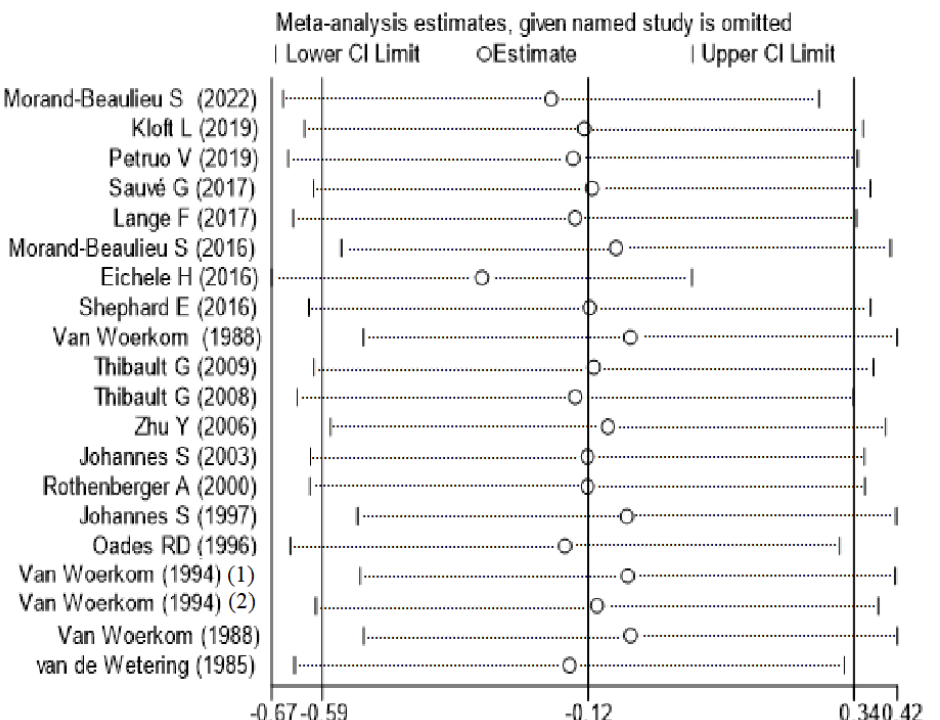
Figure 3. Sensitivity analysis of P3b amplitude of TD patients and HCs. CI confidence interval.